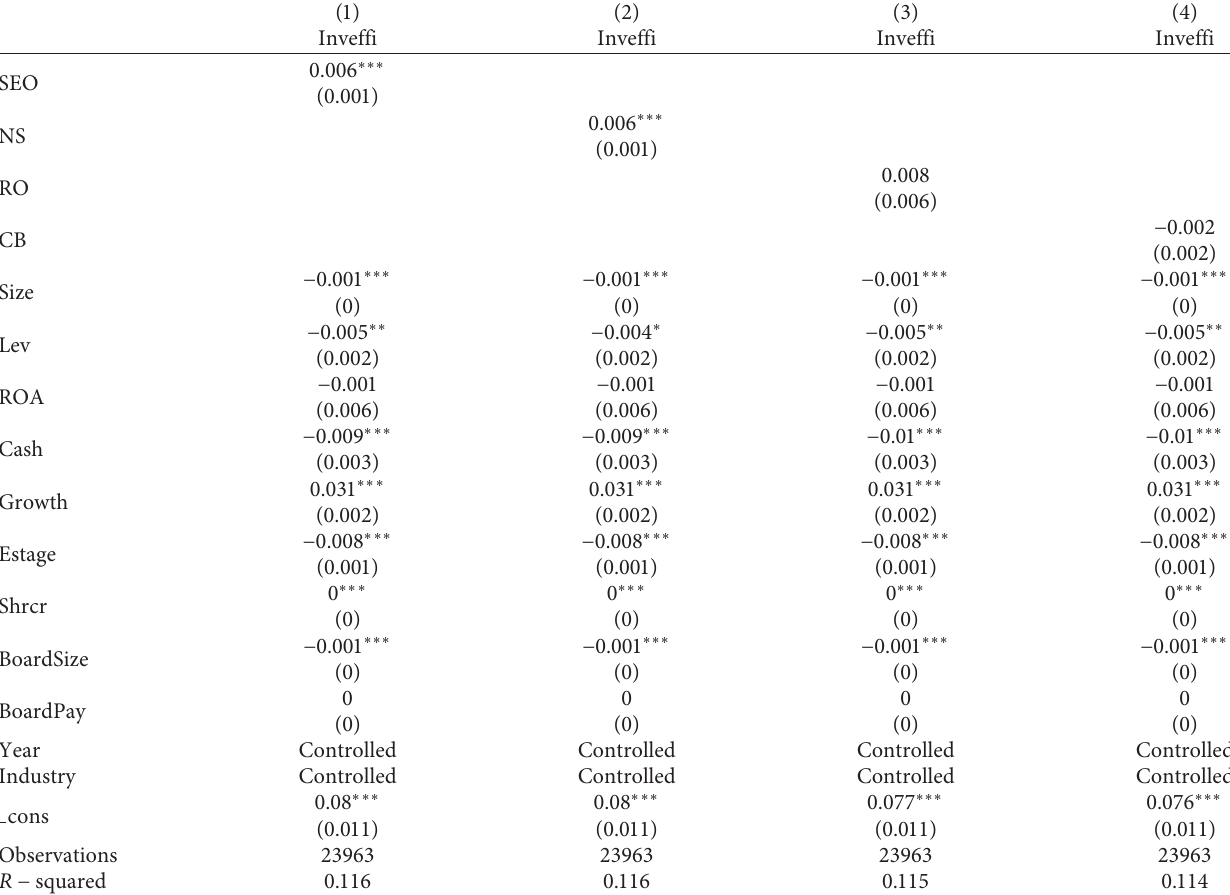
Table 4: Regression results of the relationship between SEO and investment efficiency.